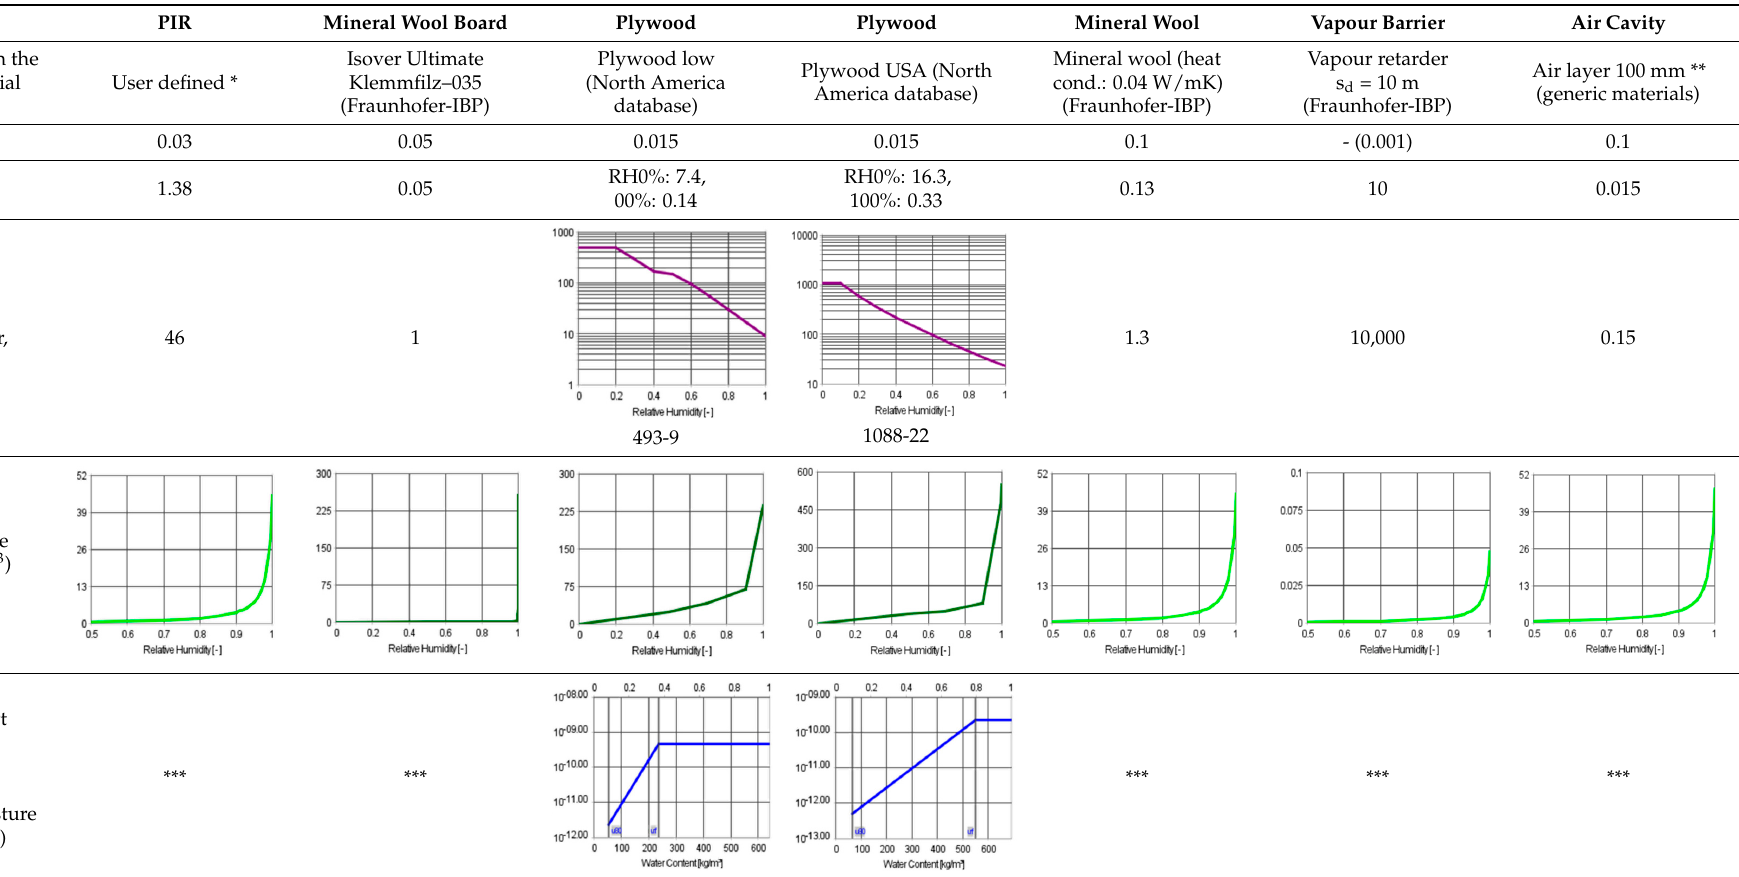
Table A1. Properties of materials used in simulations. The material properties are mainly obtained from the WUFI ® Pro material database [17]. The exception is the material properties of the PIR insulation, which is defined based on input from the producer of the façade solution. The images illustrating the material properties are obtained from the WUFI ® Pro Software [17].